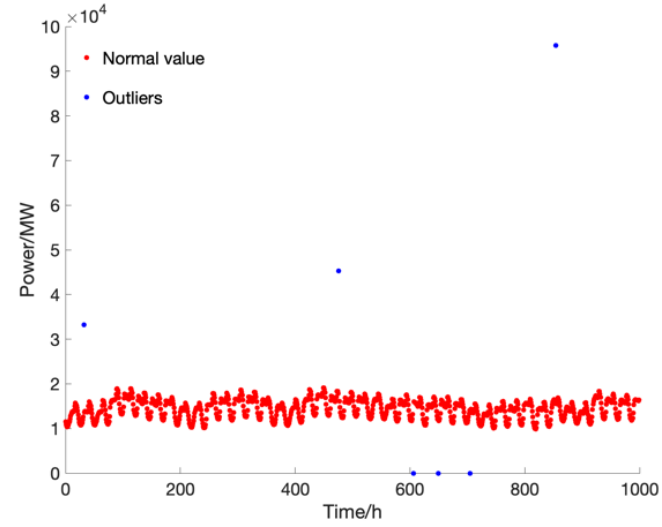
Figure 6. DBSCAN clustering diagram. The root mean square error (RMSE) and mean absolute percentage error (MAPE) are used as the evaluation indicators in this paper. The smaller the value of evaluation indicators, the higher the forecast accuracy.